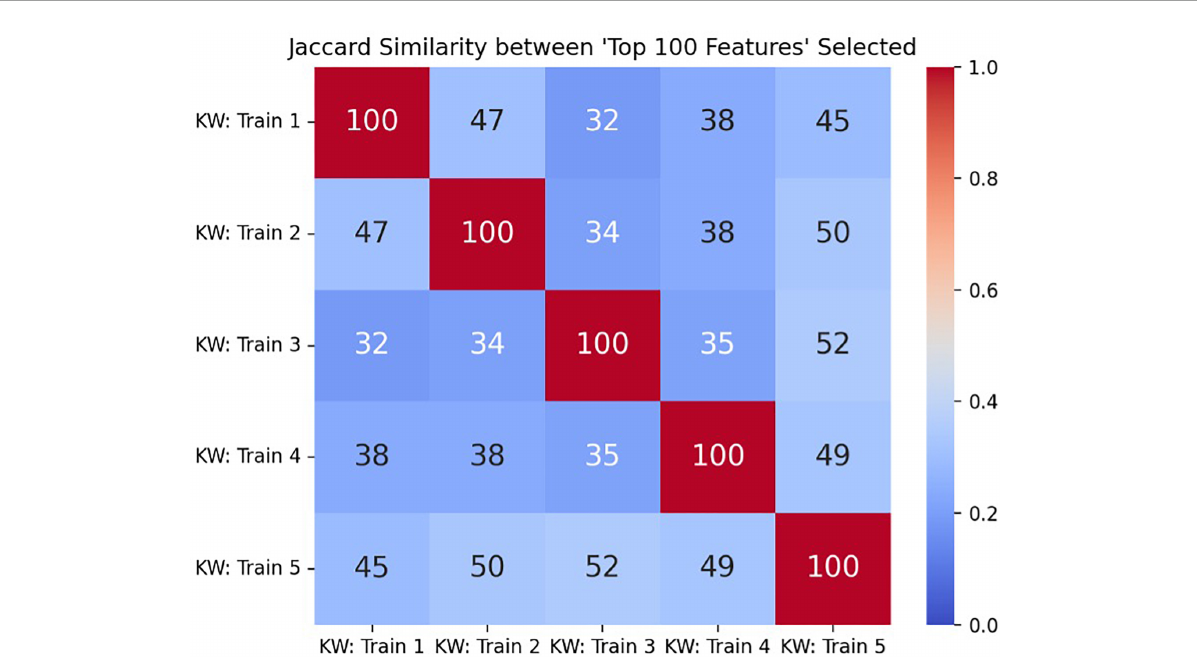
FIGURE2 The Jaccard similarity score comparing all pairs of “top 100 variables” rankings lists, with the true size of the intersection (number of shared VDT performance variables selected in both intermediate rankings lists) annotated in each